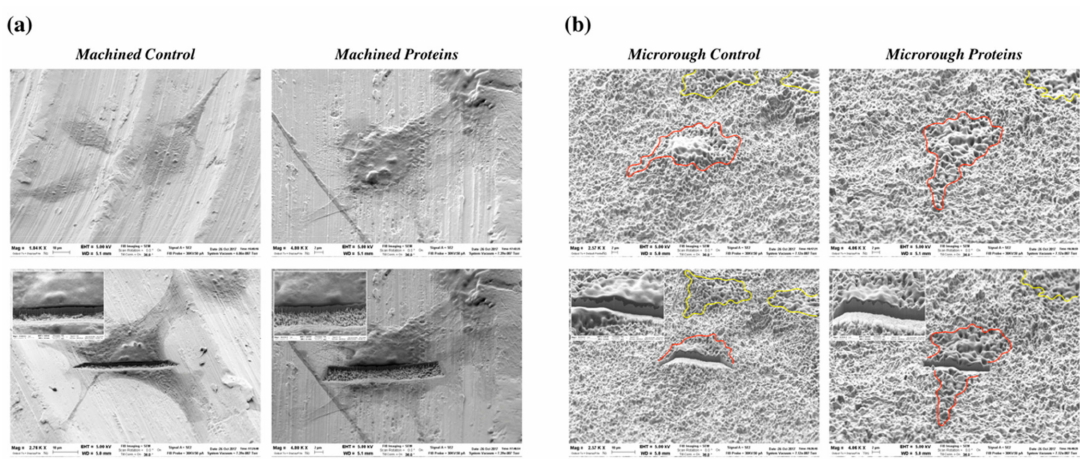
Figure 4. Scanning electron microscopy: ( a ) Representative SEM images showing MC3T3-E1 cells 24 h after seeding on machined titanium surfaces pre-conditioned or not with serum proteins, before and after focused ion beam (FIB) cross-sectional analysis; ( b ) representative SEM images showing MC3T3-E1 cells 24 h after seeding on microrough titanium surfaces pre-conditioned or not with serum proteins, before and after FIB cross-sectional analysis. Red and yellow lines highlight the borders of osteoblasts on titanium